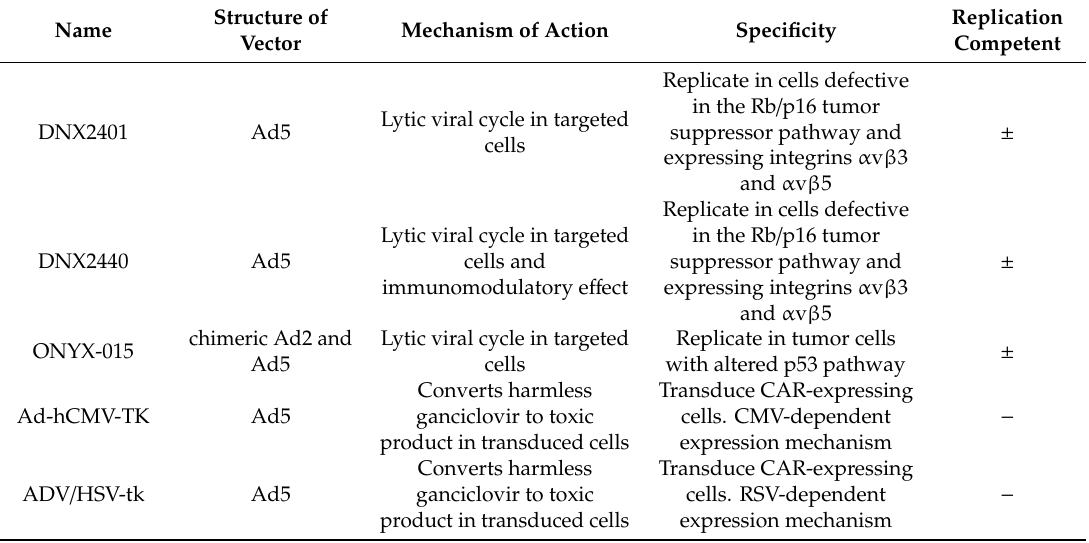
Table 1. Comparison of key features of viral vectors proposed for treatment of